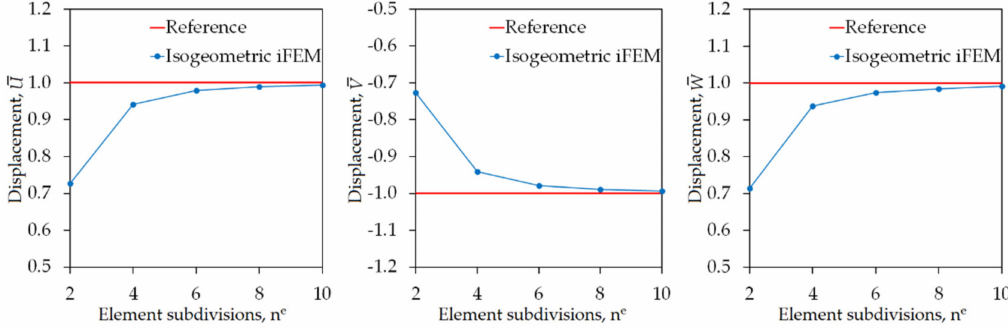
Figure 11. Convergence of maximum values of U , V , W displacements, versus increasing number of element subdivisions n e for